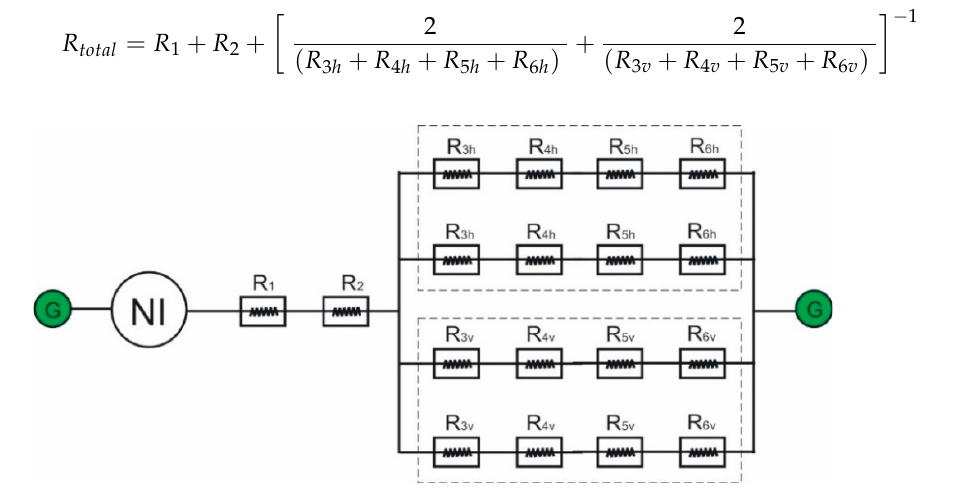
Figure 7. Complete circuit form of the electromagnetic circuit.